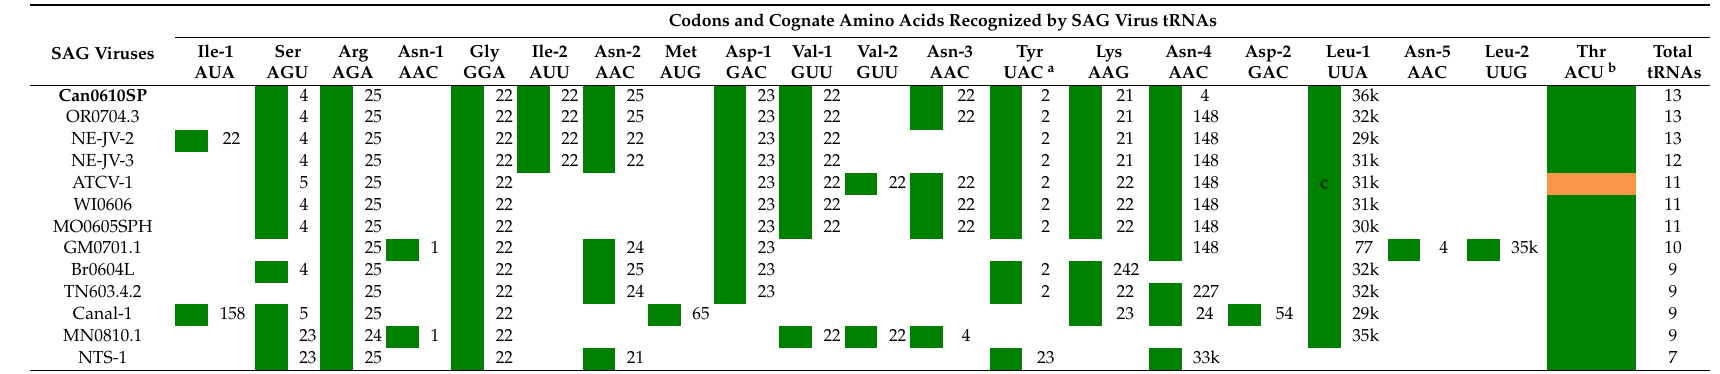
Table 2. The order of clustered tRNA genes in SAG chloroviruses 1